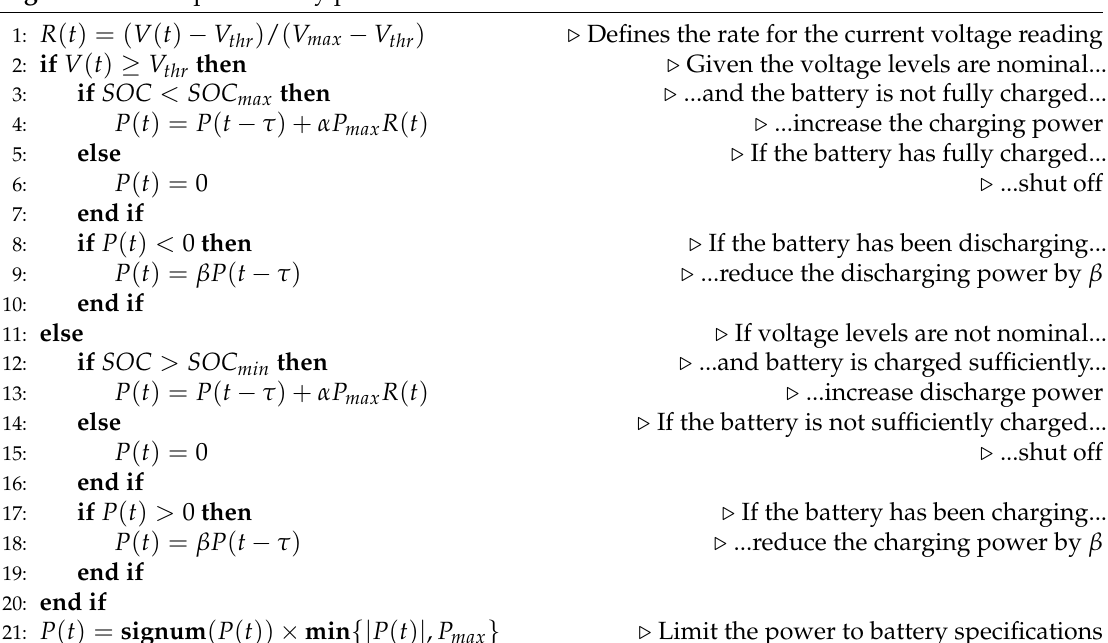
Algorithm 1 Compute battery